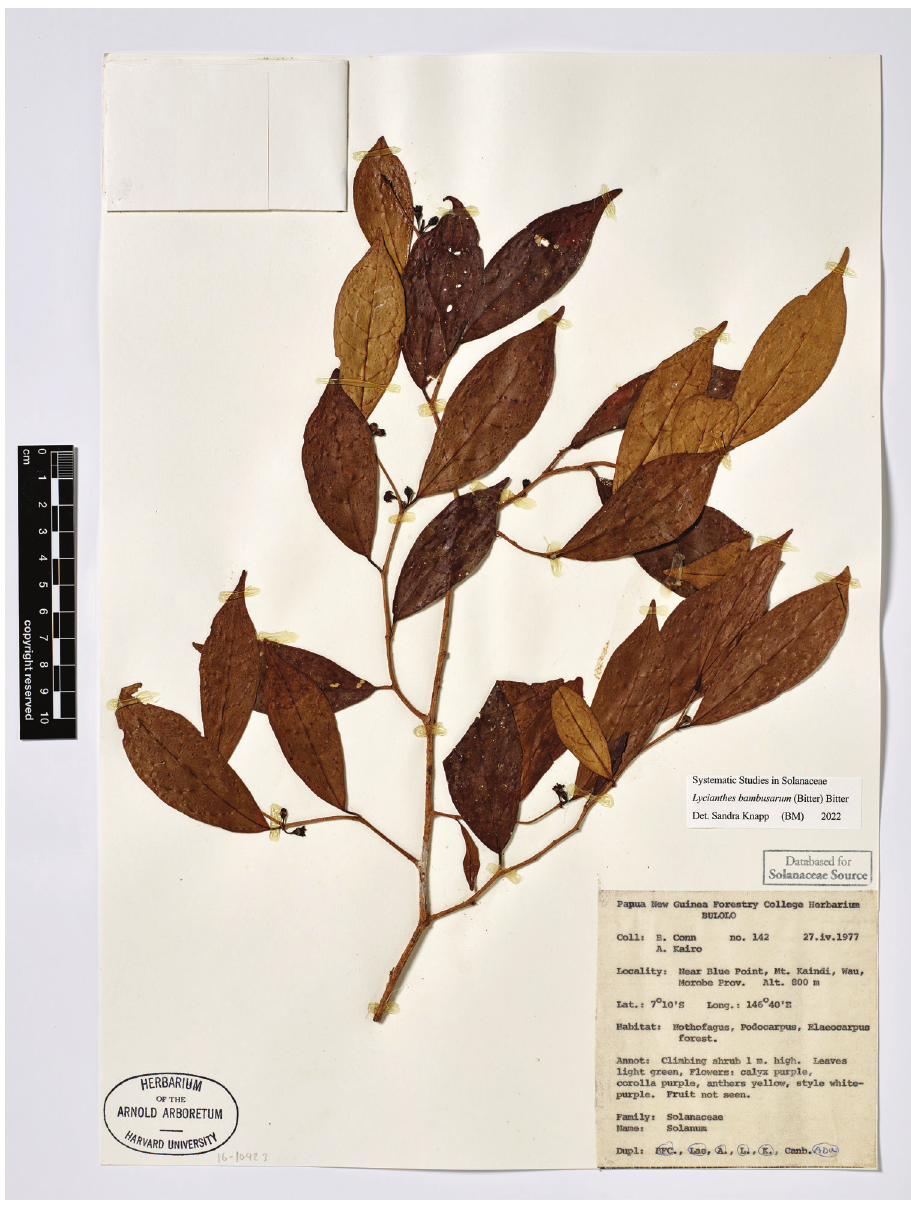
Figure 5. Lycianthes bambusarum herbarium specimen. Papua New Guinea. Morobe: Conn & Kairo 142 (A). Courtesy of the Herbarium of the Arnold Arboretum of Harvard University, reproduced with